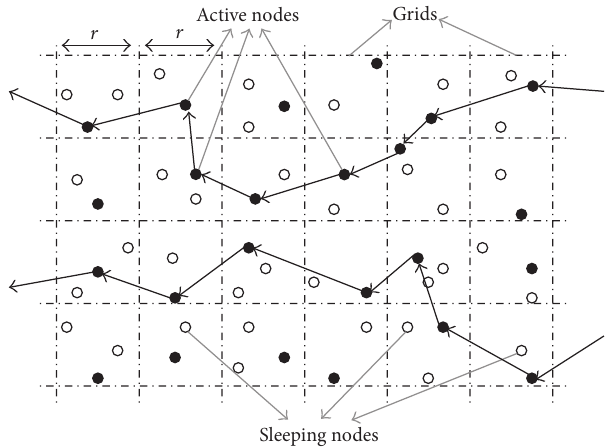
Figure 1: Example of routing data using virtual grids in